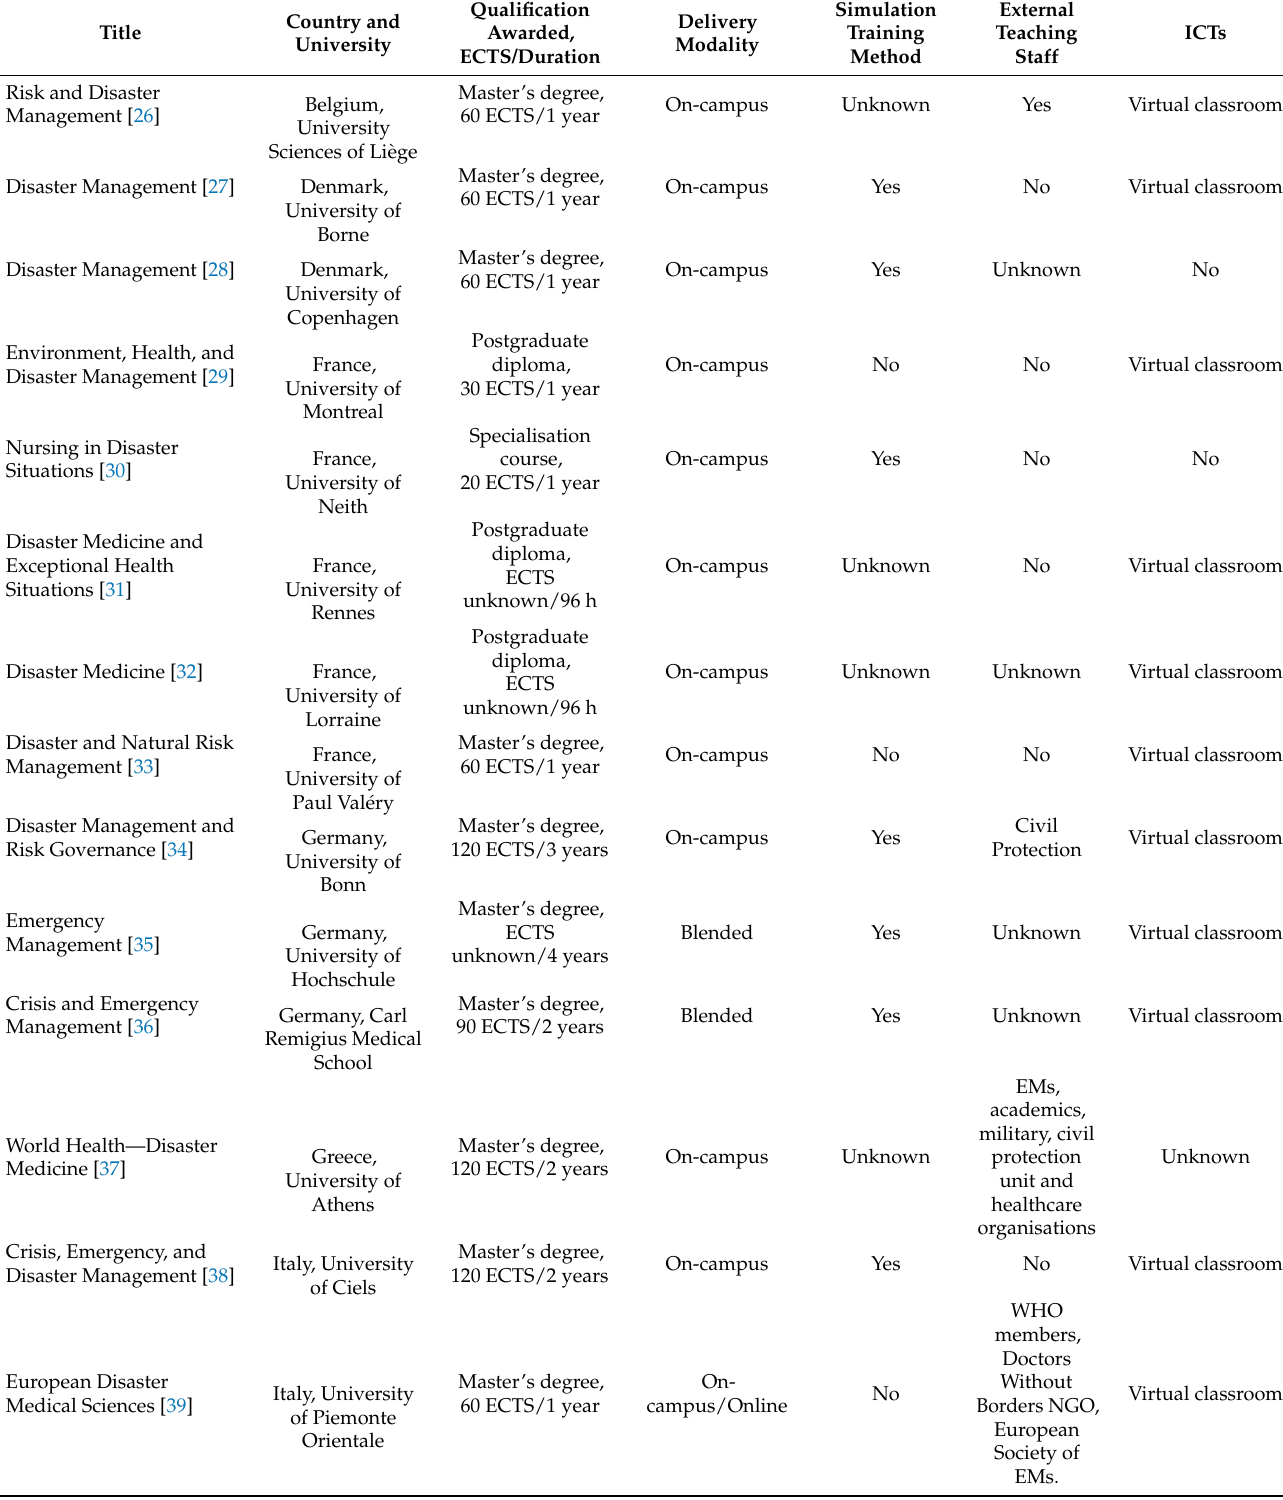
Table 1. Characteristics of the educational programmes in disaster management assessed in this